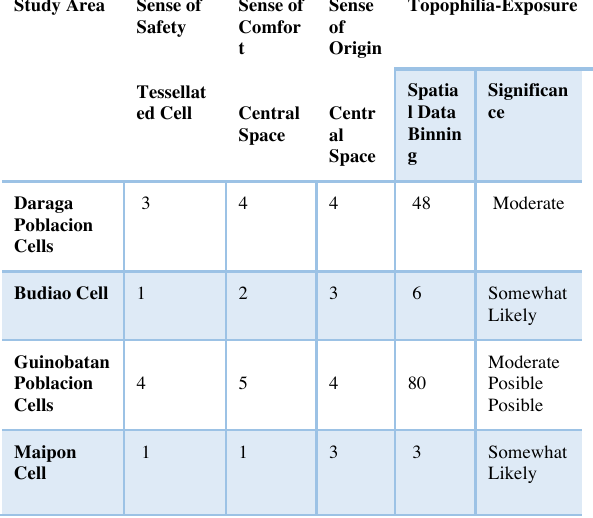
Table1 Topophilia Exposure Findings Binned Sense of Comfort/Origin Rating: 1 = Least sense of comfort/origin